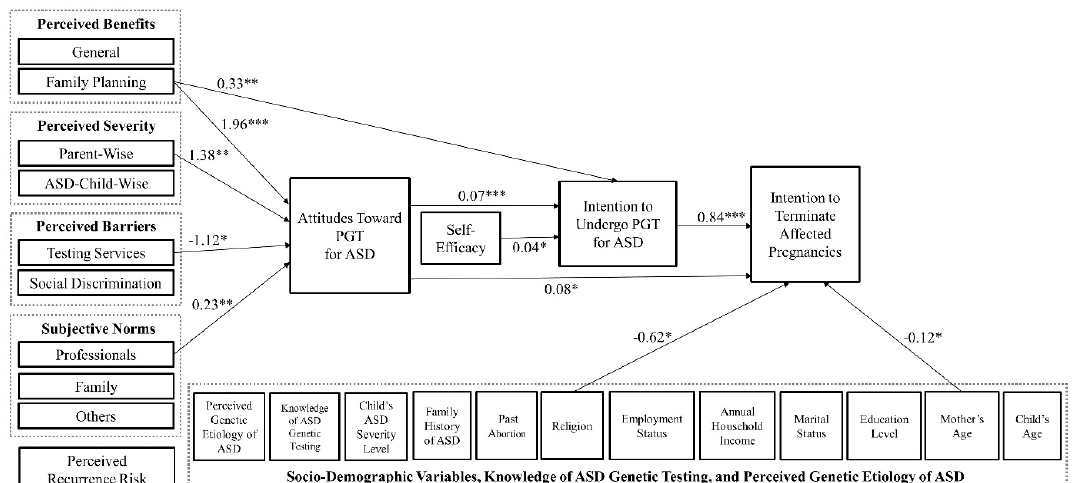
Figure 1. Structural model: factors associated with intention to undergo prenatal genetic testing (PGT) fordetectingautismspectrumdisorders(ASD)susceptibilitygenesandtoterminatea ff ectedpregnancies among Taiwanese mothers of children with ASD in our sample, controlling for socio-demographic variables, knowledge, and perceived genetic etiology of ASD. Due to the multicollinearity related to the child’s age, time since ASD diagnosis was not included in this final model. Only the statistically significant associations (represented using solid lines) are presented in this figure. * p < 0.05. ** p < 0.01. *** p <